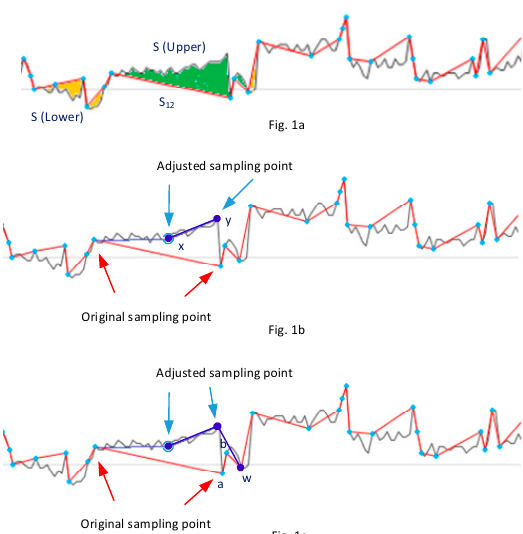
Figure 1. Difference of original and inferred value with gaps ( a ) and adjusted sampling data point to improve the accuracy ( b ). This can be improved with further adjustment to compensate for efficiency by matching the data points samples ( c ).